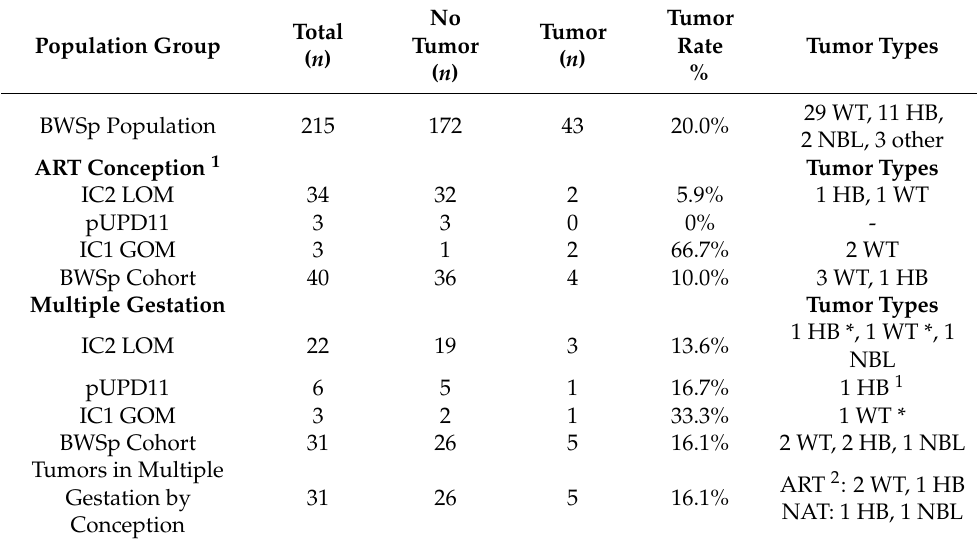
Table 3. Rate of tumor development among ART conception and multiple gestation